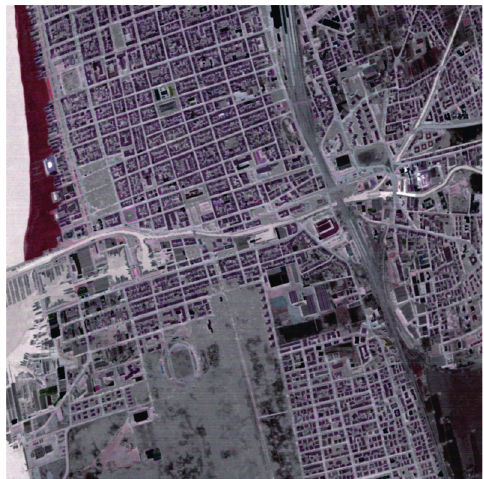
Fig. 4. MIVIS composite image acquired over Via- reggio and obtained mapping the 100th channel as red, the 95th channel as green and the 93rd channel as